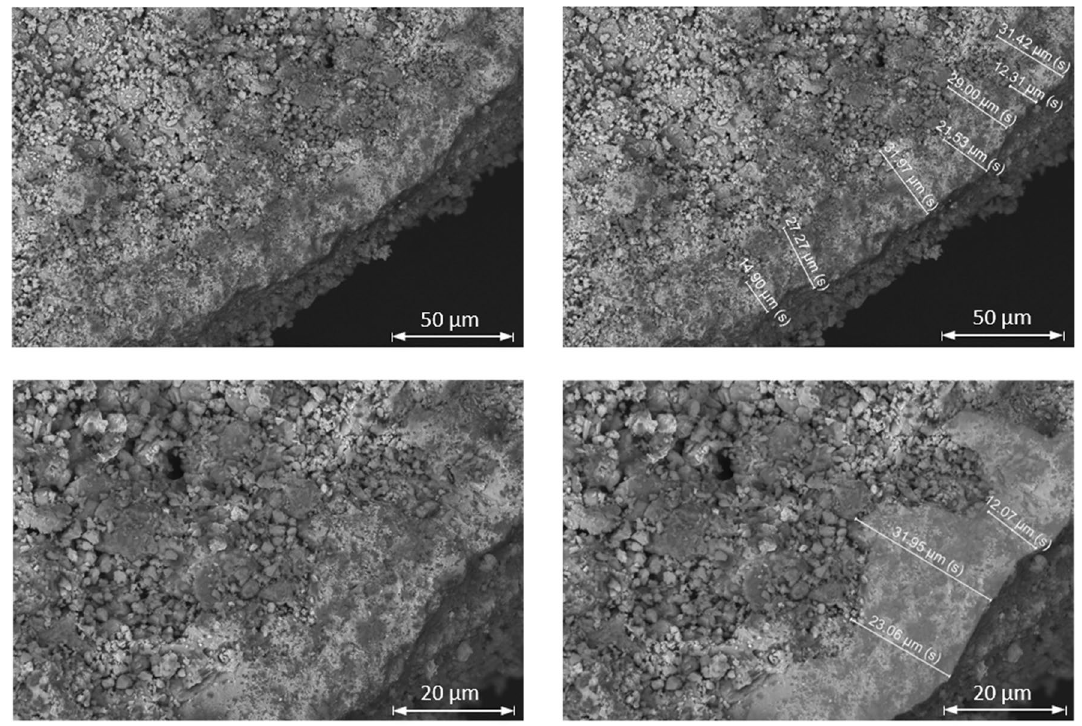
Fig. 4 SEM raw images of the cross section of a bisected Ni-MOF-74@Al 2000 ( b ) with additional auxiliary lines color accentuation for highlighting the Ni-MOF-74 shell